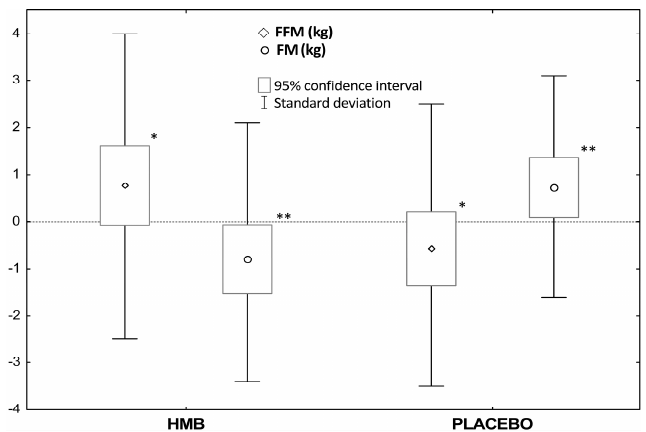
Figure 2. Changes in body composition after 12-week supplementation of HMB and placebo. Values are means ± SD and 95% CI. Abbreviations: HMB, β -hydroxy- β -methylbutyric acid; FFM, fat-free mass; FM, fat mass. Significant differences compared with placebo: * p = 0.049 (dependent samples t -tests), ** p = 0.016 (dependent samples t -tests).